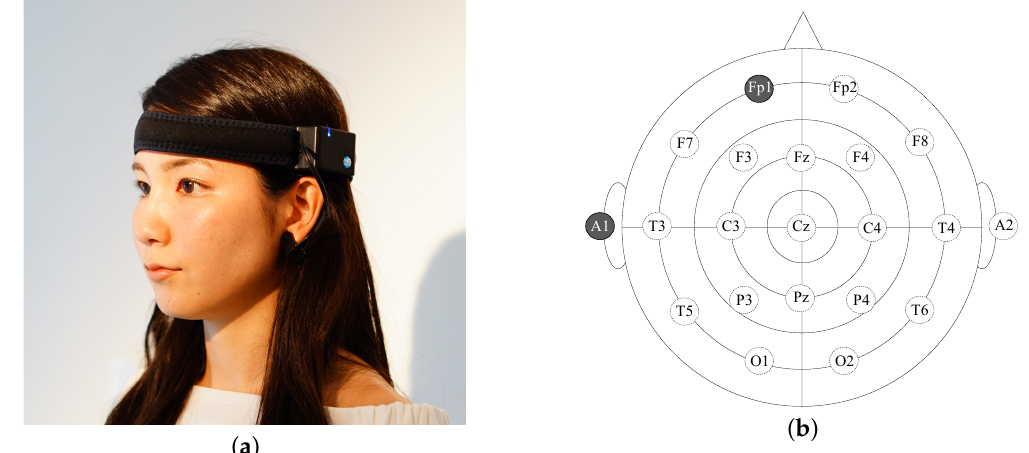
Figure 1. ( a ) The portable electroencephalogram (EEG) device makes use of two electrodes, one of which is positioned on the left prefrontal region (Fp1) and the other of which is positioned on the left earlobe (A1). EEG data are transferred to a smartphone via Bluetooth. The portable device uses a lithium-ion rechargeable battery; ( b ) the international 10–20 system and the measurement points used by our device